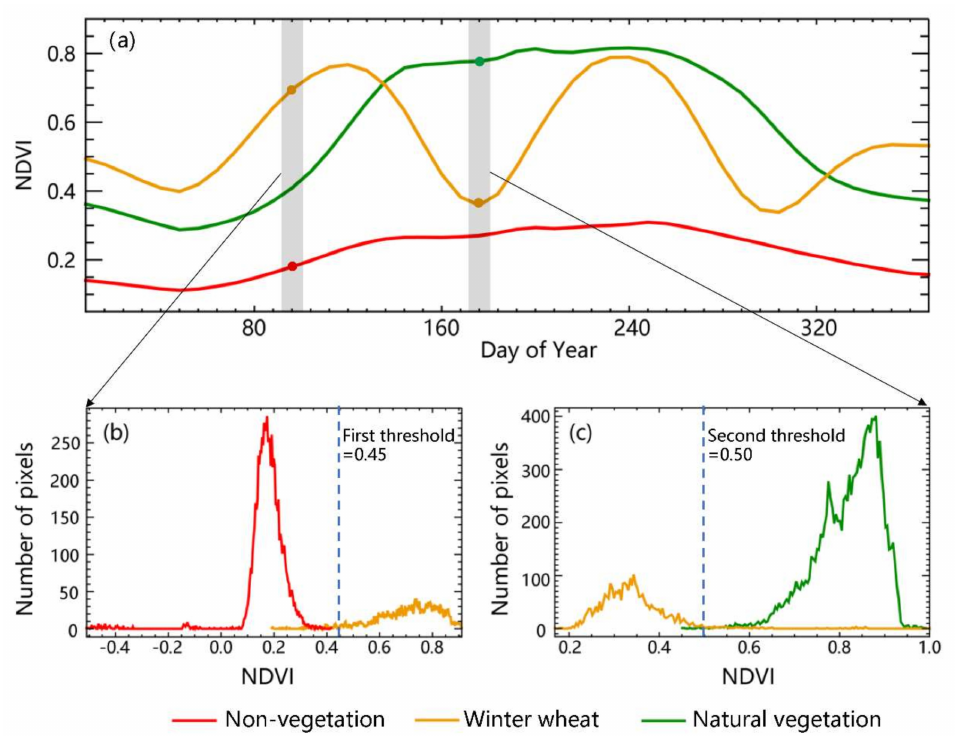
Figure A1. Statistical characteristics of NDVI for winter wheat and other land cover types in NCP: ( a ) the average NDVI time-series curves for di ff erent land cover types; ( b ) the NDVI histogram for non-vegetation and winter wheat based on the 12th NDVI image (about late March); ( c ) the NDVI histogram for winter wheat and natural vegetation based on the 22nd NDVI image (about late June). Note that the two peaks in the NDVI time-series curve is because of winter wheat–summer maize